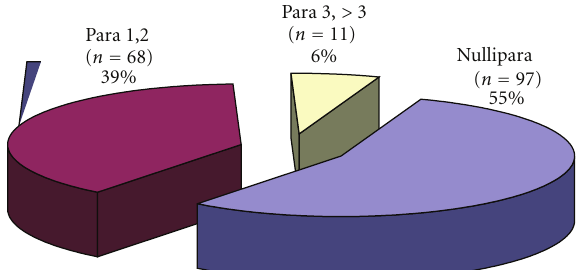
Figure 3: Incidence of myomas related to parity in laparoscopic my- omectomies.